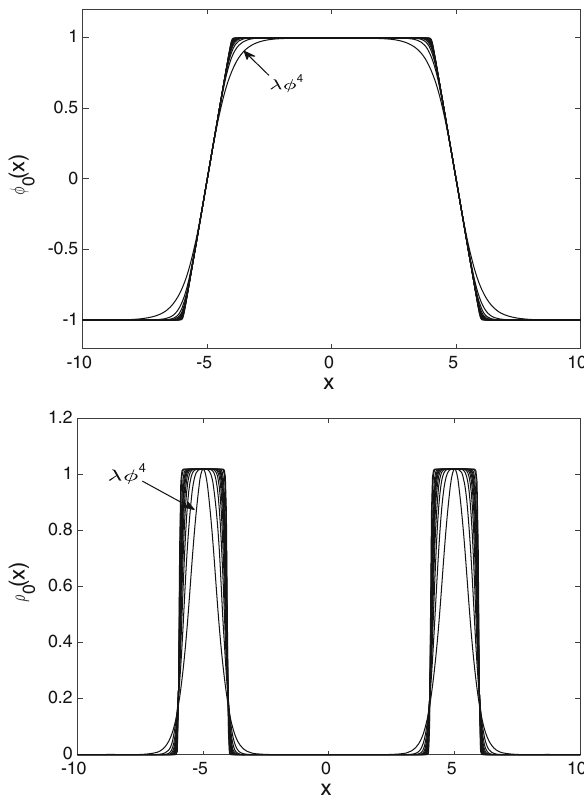
Fig. 2 (Top panel) The profile of the initial data (15) for successive values of n varying from n = 1 corresponding to the φ 4 model, up to n = 20. (Bottom panel) The initial configuration of the energy density corresponding to the configuration in the top panel